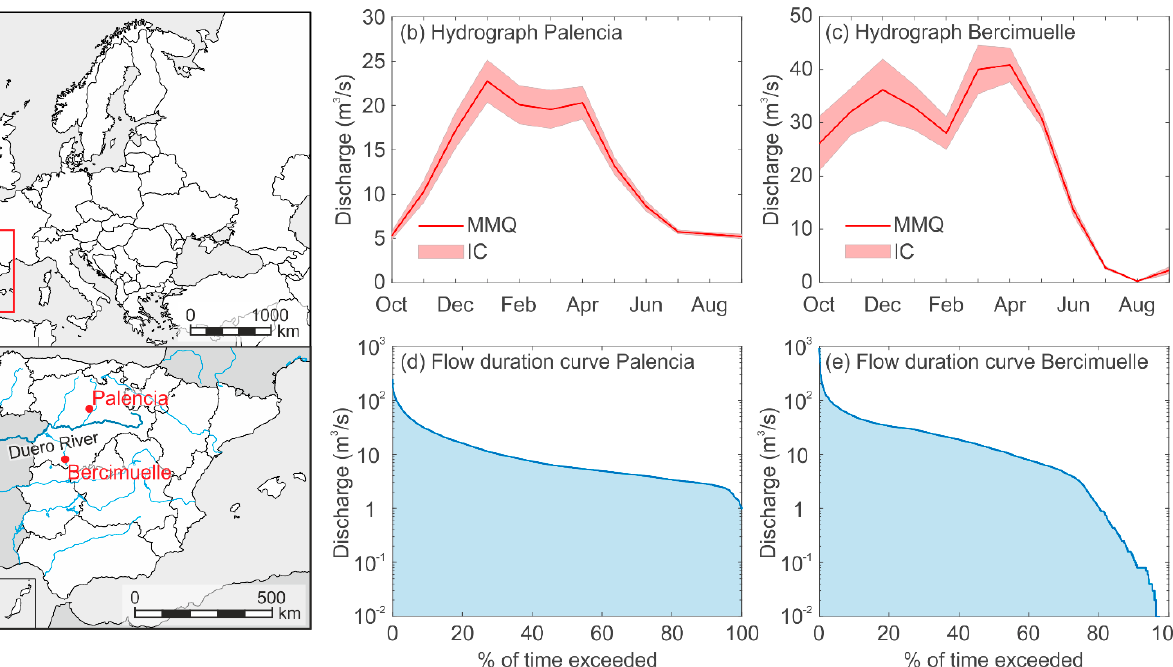
Figure 3. Situation map and hydrograph of the two studied flat-V gauging weirs: ( a ) the Iberian Peninsula with bold-lined Duero River and red dots representing the study sites (Palencia and Bercimuelle); ( b , d ) Hydrograph and flow duration curve of the Palencia weir (data series: 1997–2018); ( c , e ) Hydrograph and flow duration curve of the Bercimuelle weir (data series: 1997–2018). MMQ stands for the mean monthly discharge and IC for the confidence interval.